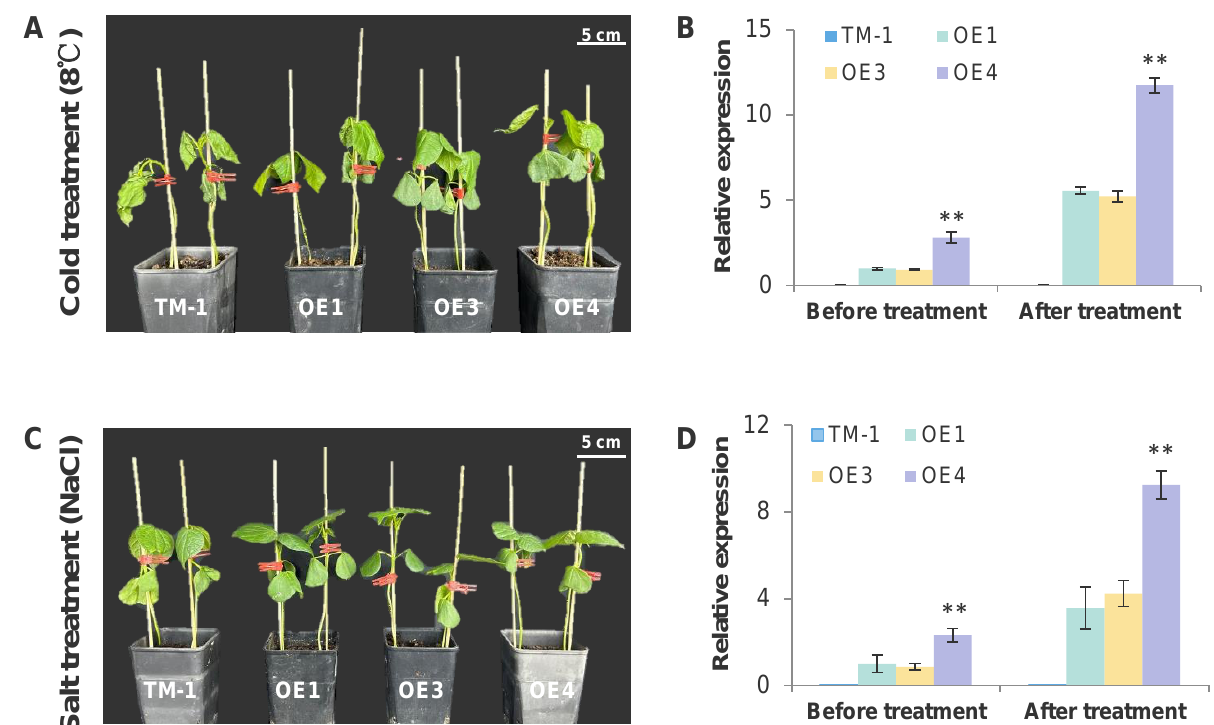
Figure 9. Cold and salt treatment and relative overexpression of com58276 . ( A ) The phenotype of TM-1 and OE1, OE3, and OE4 cotton under cold treatment (8 ◦ C). ( B ) The expression of com58276 after cold treatment. Values represent the mean ± S.D ( n = 3 replicates). ** p < 0.01; Dunn’s test. ( C ) The phenotype of TM-1 and OE1, OE3, and OE4 cotton under salt treatment (300 mM NaCl). ( D ) The expression of com58276 after salt treatment. Values represent the mean ± S.D ( n = 3 replicates). ** p < 0.01; Dunn’s